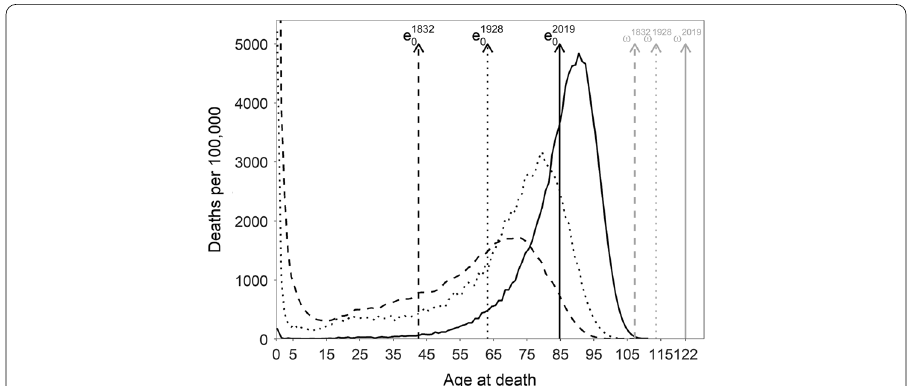
Fig. 1 Age-at-death distributions for Swedish females in 1832 (dashed), 1928 (dotted), and 2019 (solid). Black and grey vertical lines refer to life expectancy and record lifespan up until that year, respectively (Source: Authors’ elaboration based on the HMD